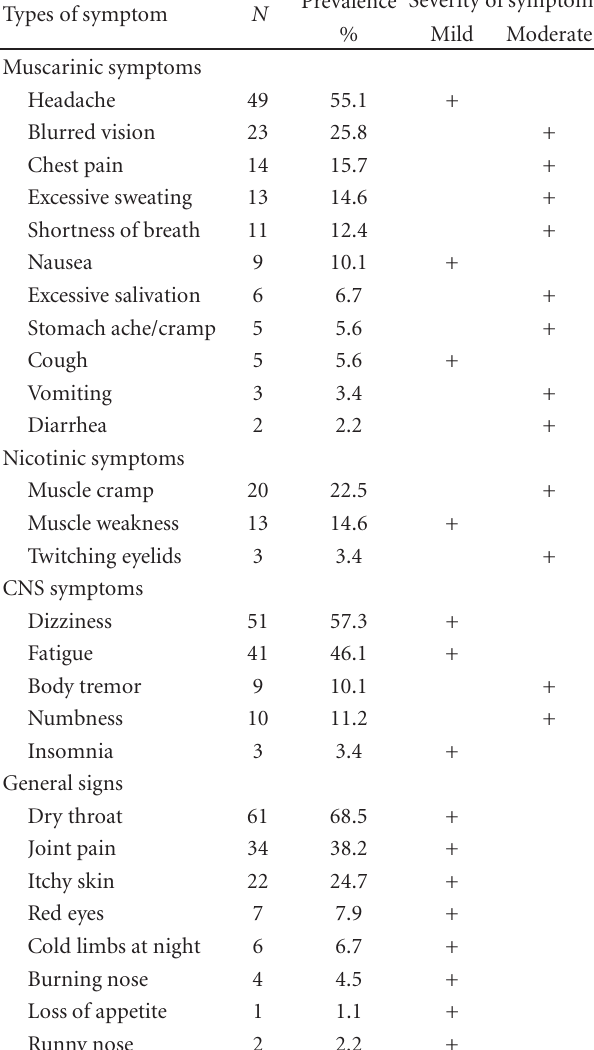
Table 3: Personal protective measures adapted by 89 farmers in relation to spraying pesticides in Boeung Cheung EK Lake, Phnom Penh, Cambodia.